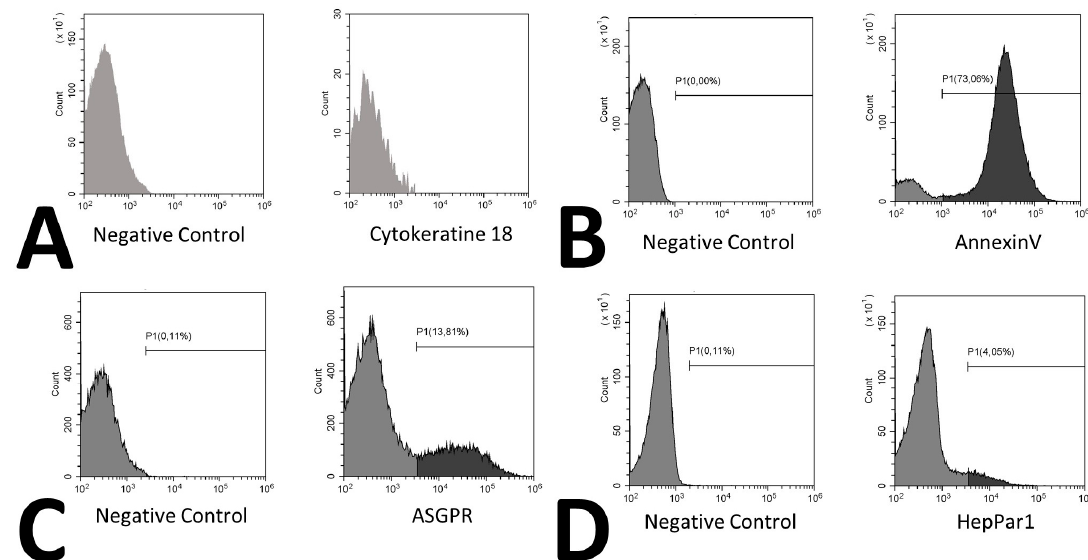
Figure 4. Histograms of extracellular vesicle staining. Histograms for cytokeratine 18 labeled with FITC ( A ), Annexin V labeled with PE-Cy7 ( B ), ASGPR labeled with APC ( C ), and HepPar1 labeled with PE ( D ) are shown. Histograms from Annexin V, ASGPR and HepPar1 are derived from the same